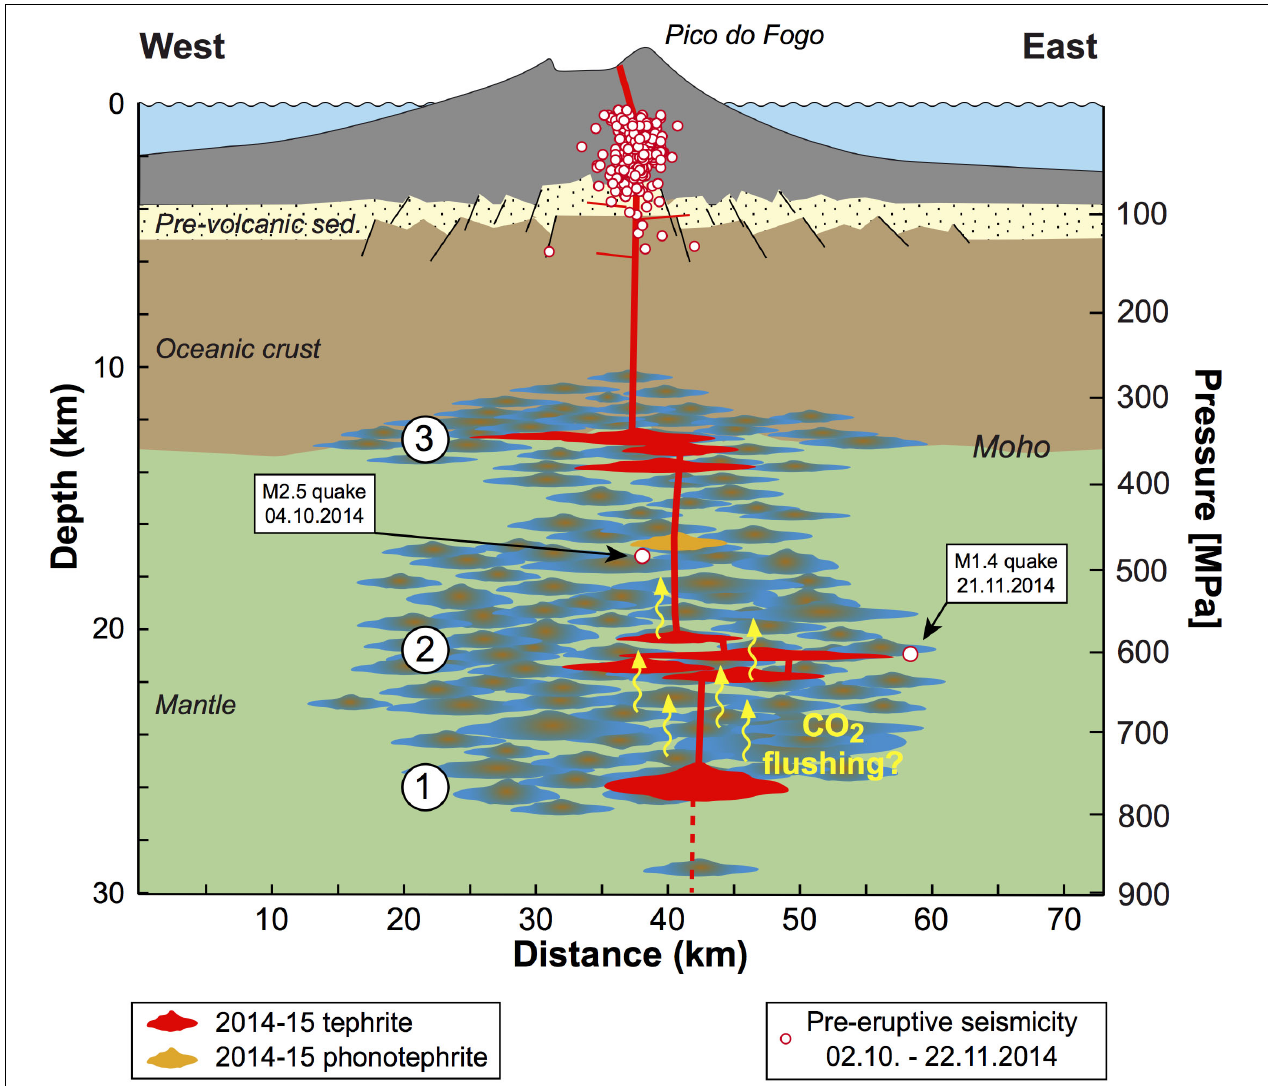
FIGURE 11 | Cross-section of Fogo (2x vertical exaggeration) with lithological boundaries after the crustal model of Pim et al. (2008), showing the inferred magma plumbing and seismic precursors of the 2014–2015 eruption. Magma storage in the uppermost mantle is envisaged as a complex system with interconnected small pockets or compartments, in which batches of melt can evolve separately. This allows compositionally diverse magmas to be discharged in a single eruption (Klügel et al., 2005; Gudmundsson, 2012; Hildner et al., 2012). Major magma storage levels for the 2014–2015 magmas are indicated: (1) storage and crystal fractionation before eruption as indicated by clinopyroxene cores; (2) temporary stalling (near-isobaric magma flow) in a complex storage zone as indicated by clinopyroxene rims; (3) temporary stalling in a magma accumulation zone near the Moho as indicated by fluid